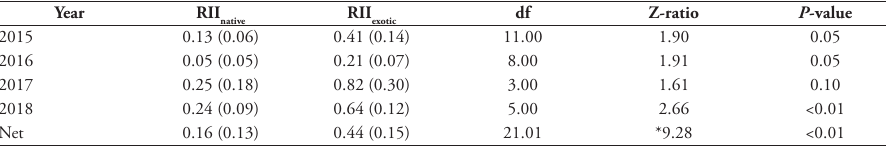
*F-value; see Suppl. material 1: Table A5 for complete